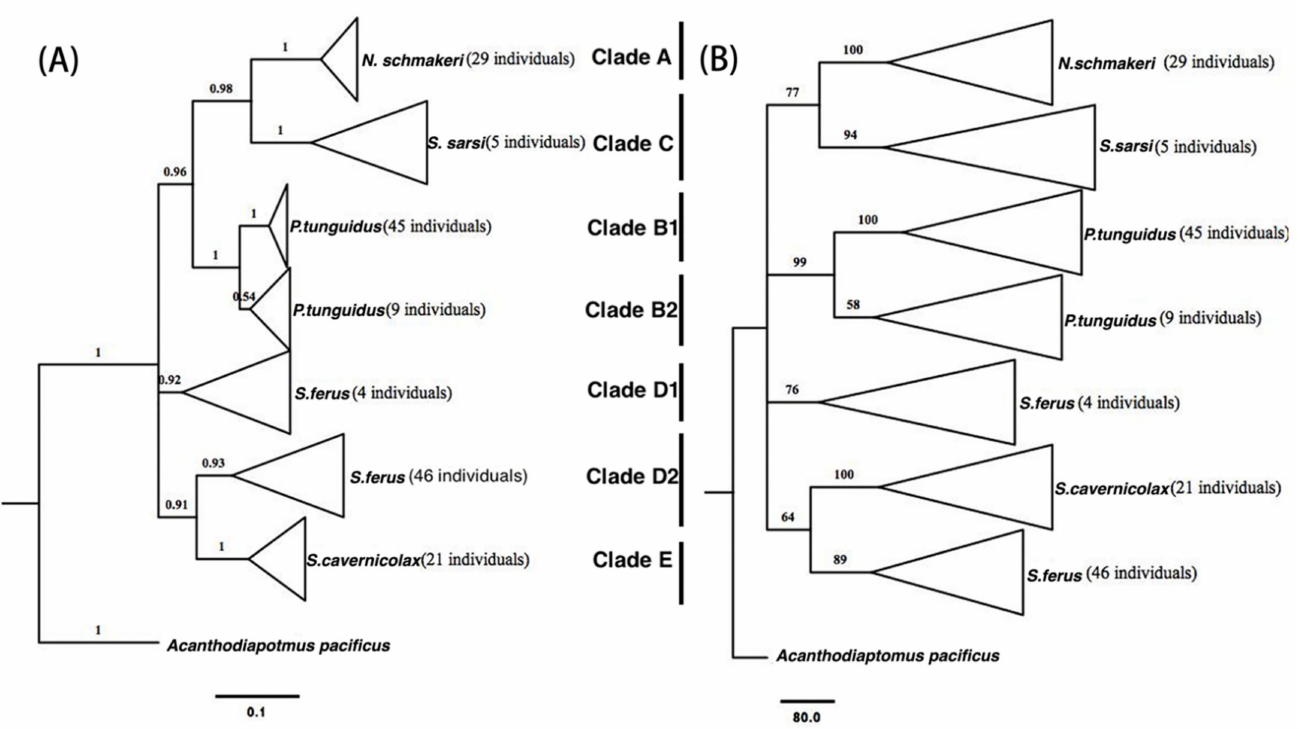
Figure 2. Phylogenetic tree of investigated species based on the sequences of their COI genes by Bayesian inference ( A ) and maximum likelihood method ( B